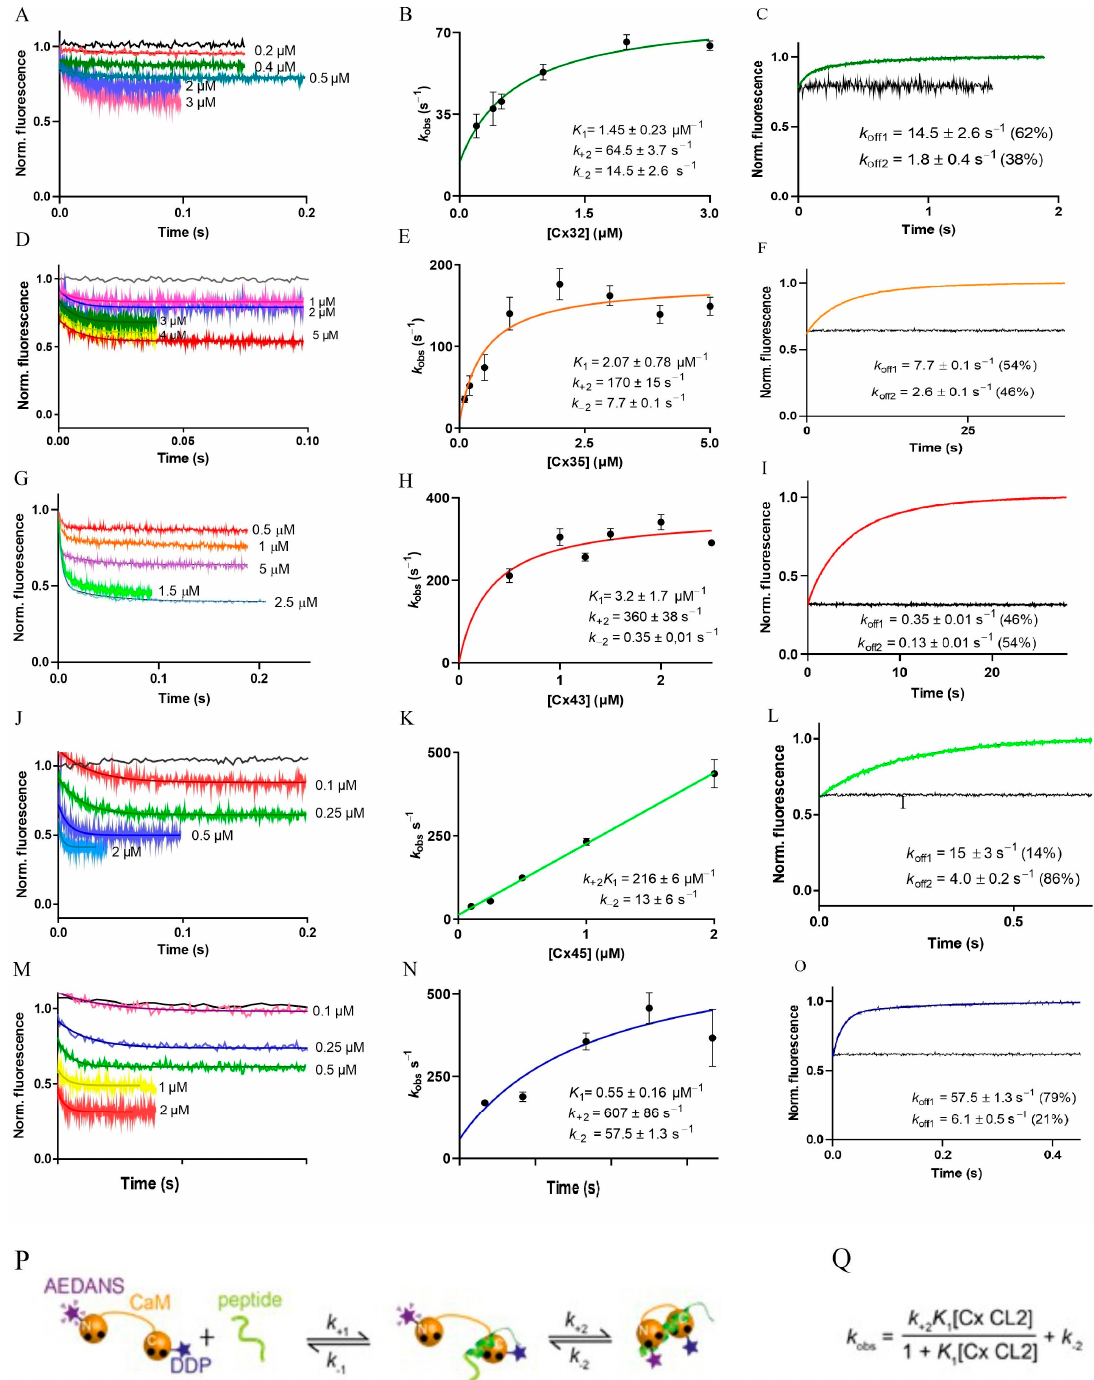
Figure 3. Association and dissociation kinetics of Ca 2+ /DA-CaM and ( A – C ) Cx32 CL2, ( D – F ) Cx35 CL2, ( G – I ) Cx43 CL2, ( J – L ) Cx45 CL2 and ( M – O ) Cx57 CL2 peptides. ( A , D , G , J , M ) Cx CL2 peptide concentration dependent association kinetic records with the corresponding mono-exponential fits. The trace at 1 represents Ca 2+ /DA-CaM mixed with buffer and the trace at 0 represents buffer